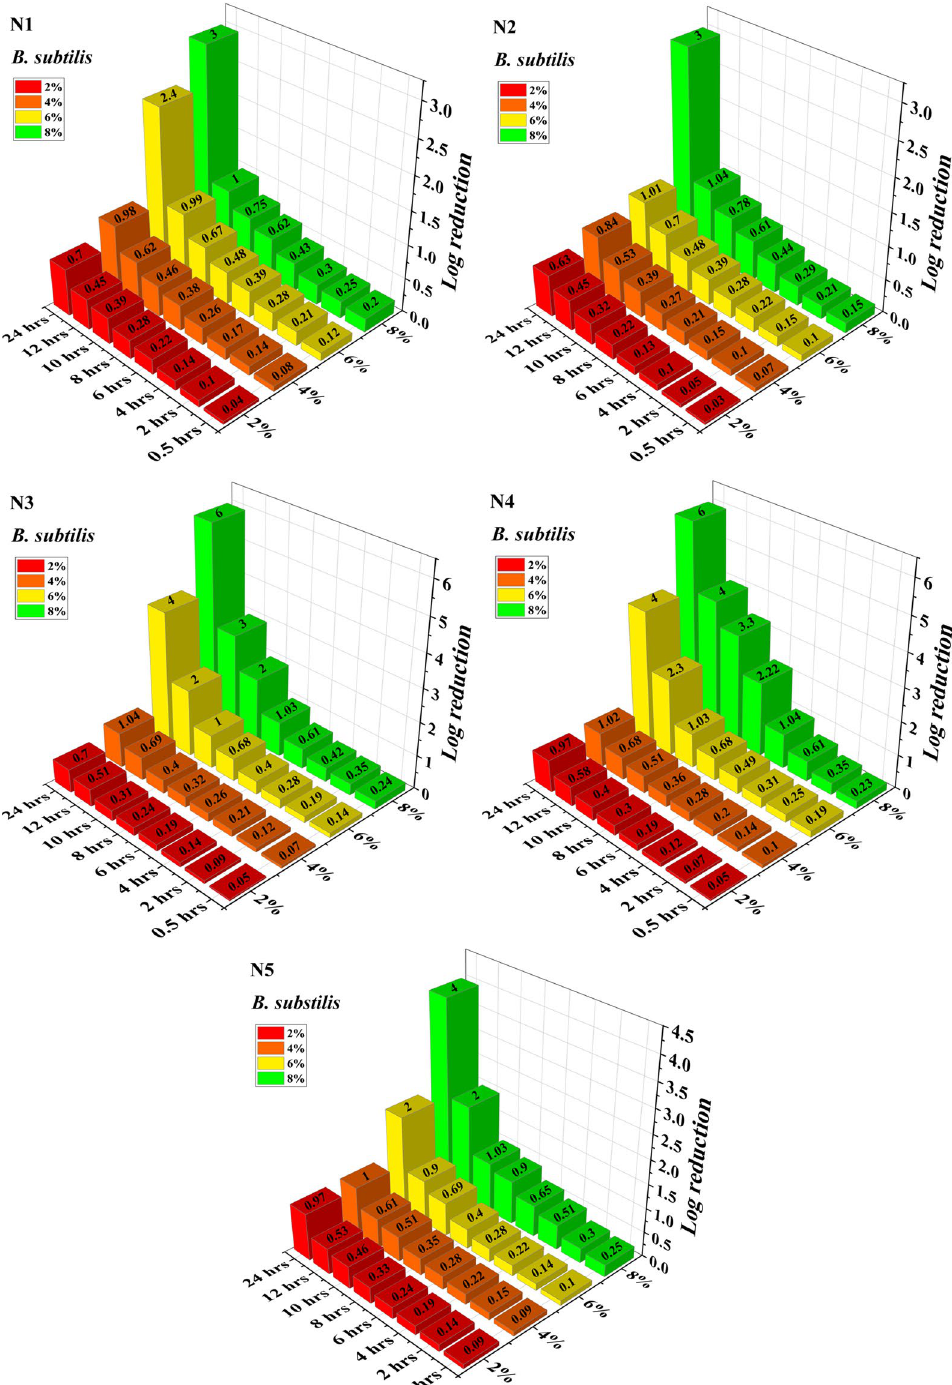
Figure 9. Log reduction of B. subtilis by acrylonitrile